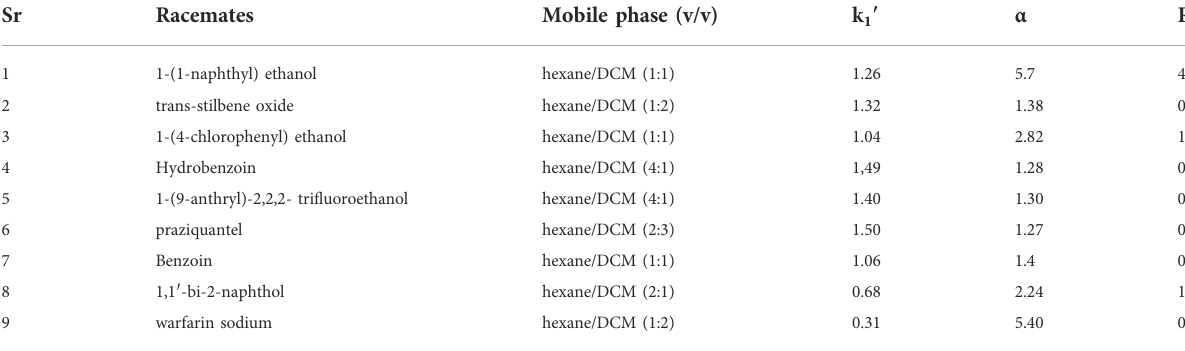
TABLE 2 Separation of Racemates on Cd-MOF column. Reproduced with permission from (Zhang et al., 2016b). Sr